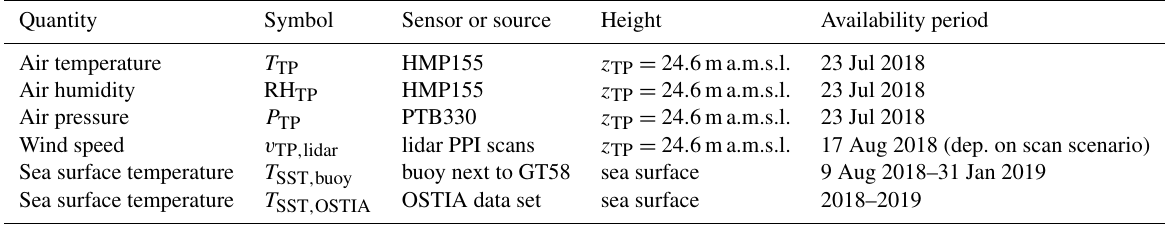
Table 4. Overview of the available meteorological quantities to derive the stability parameter ζ . Availabilities disregard shorter data gaps. If no end time is stated, measurements are ongoing with date of 1 August 2019. Additional data from mesoscale simulations similar to the New European Wind Atlas (NEWA) data set were available but not listed in this table. Quantity Symbol Sensor or source Height Availability period Air temperature T TP HMP155 RH TP